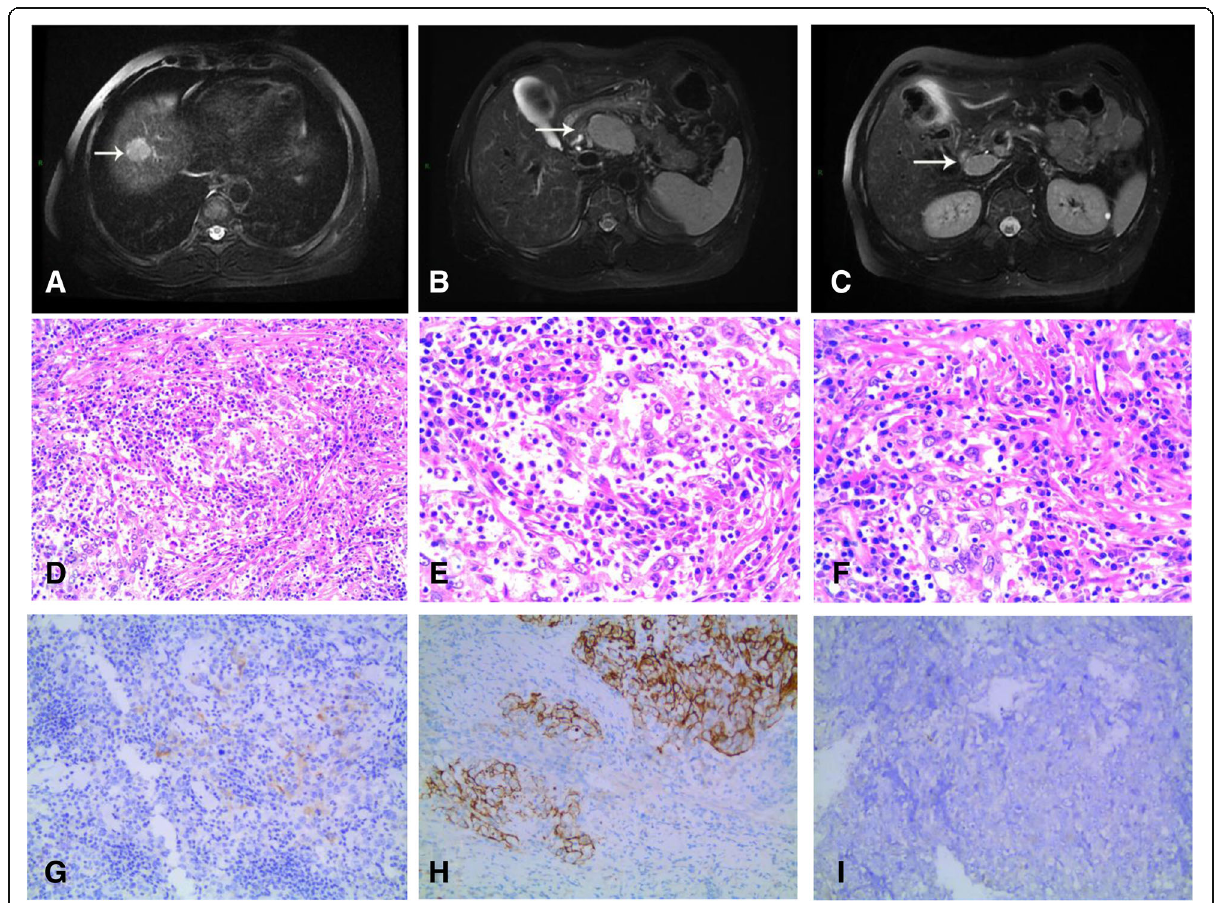
Fig. 4 Preoperative MRI findings and microscopic findings of the resected specimen. MRI showing a tumor of approximately 2.7 × 2.2 cm in segment VIII, hypointense on T1-weighted images ( a ). An enlarged lymph node can be seen on the upper margin of the pancreas, beside the common hepatic artery, approximately 5.2 × 3.4 cm in size ( b ). An enlarged lymph node is present beside the portal vein, behind the duodenal ligament ( c ). Proliferation of atypical large cells, with large nuclei and prominent nucleoli, and characterized by an eosinophilic cytoplasm. Epithelial cells were surrounded by a dense lymphoid stroma extending inside the tumor ( d , HE, × 200), ( e , HE, × 400), ( f , HE, × 400). Immunohistochemical staining for AFP and CK19 is positive ( g , HE, × 200), ( h , HE, × 200). Immunohistochemical staining for Arg and EBER is negative ( i , HE, ×